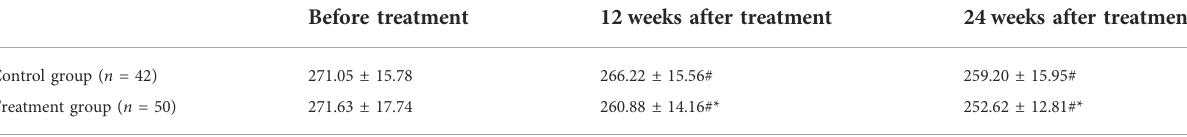
TABLE 5 Comparison of fat attenuation parameters at different time points before and after treatment in the two groups of patients (db/m). Before